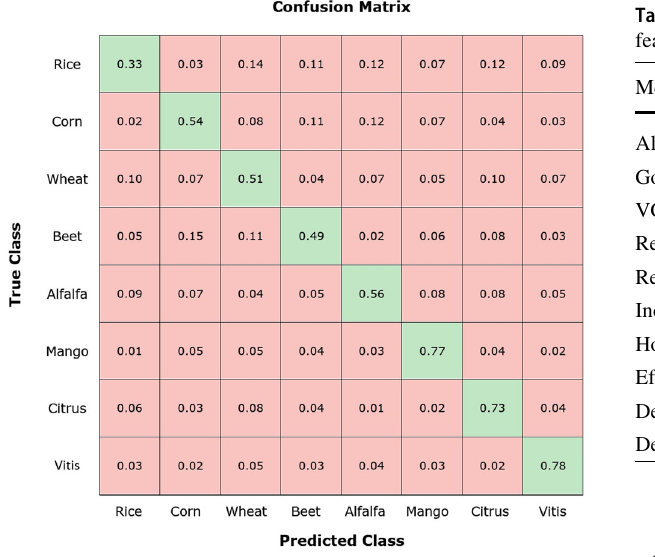
Fig. 8 Confusion matrix of the proposed method over crop-wise pest classes